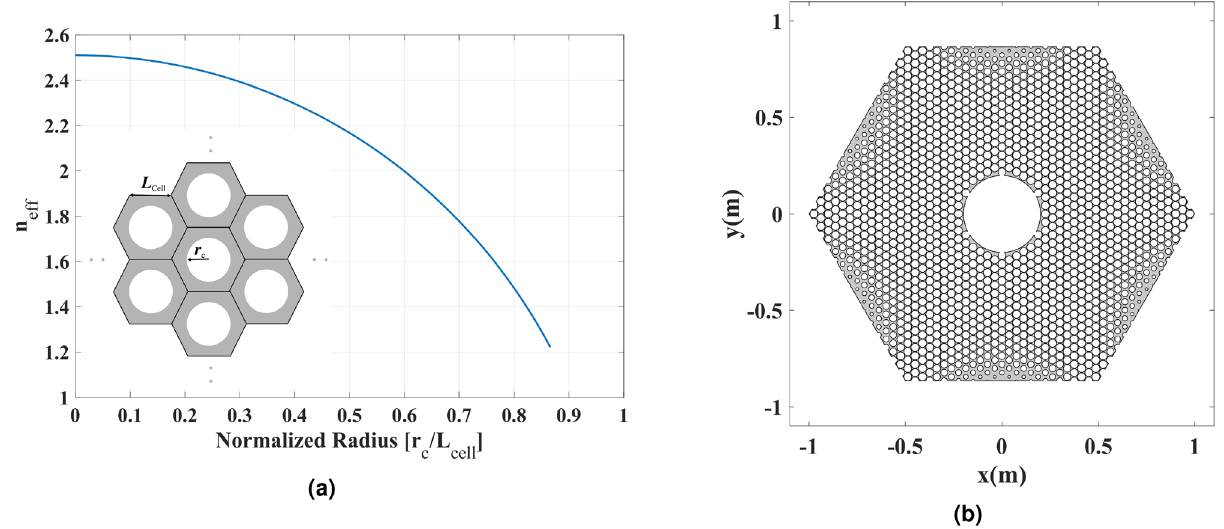
Figure 6. ( a ) The effective refractive index of a hexagonal unit cell versus r c normalized to L cell . The hexagonal lattice is illustrated in the subset. ( b ) The perforated Arlon AD600 that mimics the refractive index of Fig. 5b.